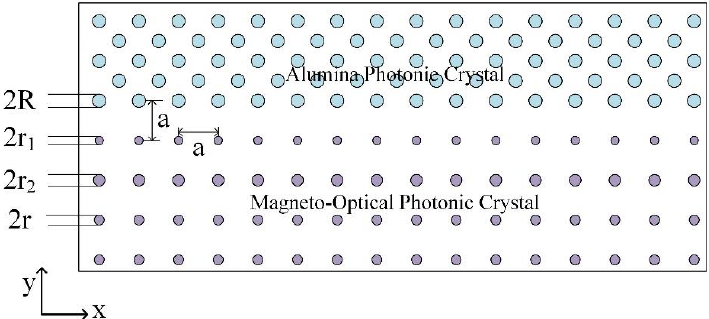
Figure 2. The geometry configuration of the one-way slow light photonic crystal waveguide (PCW). The upper half plane is still a titled 45° square lattice of Alumina PC as an ancillary cladding, and the lower half plane is a square lattice of MOPC with the rod radii of first two rows are precisely tuned. The radii of the Yttrium–Iron–Garnet (YIG) rods in the first and the second rows adjacent to the waveguide are given by 𝑟 1 and 𝑟 2 , respectively.